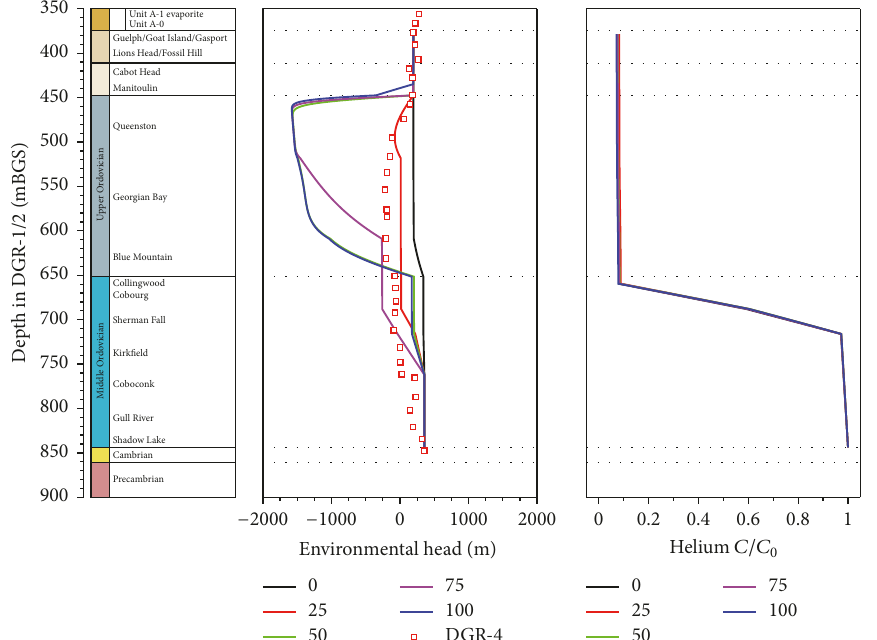
Figure 10: Simulation of helium unit tracer over 260 Ma using calibrated vertical hydraulic conductivities for glaciation scenario nn9921 for calibrations using present day environmental heads as the initial condition. Coloured lines represent different percentages of ice-sheet thickness applied as excess head to the top boundary